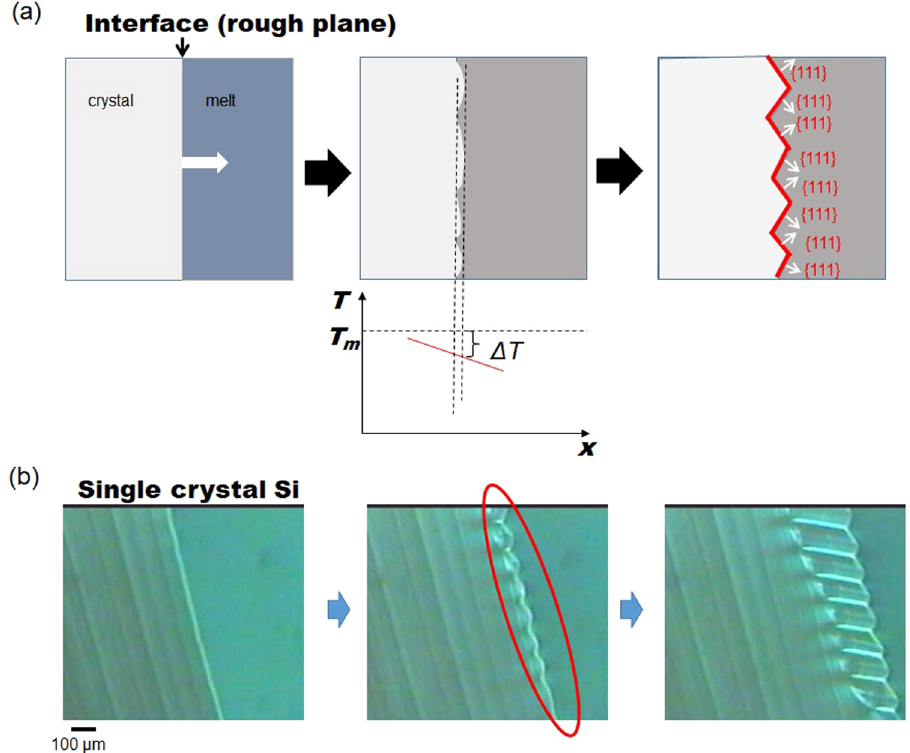
Figure 7: Process of interface instability: ( a ) schematic image of the interface at the instability with a temperature gradient at the interface. Under a negative temperature gradient, the perturbation introduced into the fl at interface is ampli fi ed, and a zigzag interface is formed fi nally and ( b ) actual images of the interface at the point of interface instability for a Si single